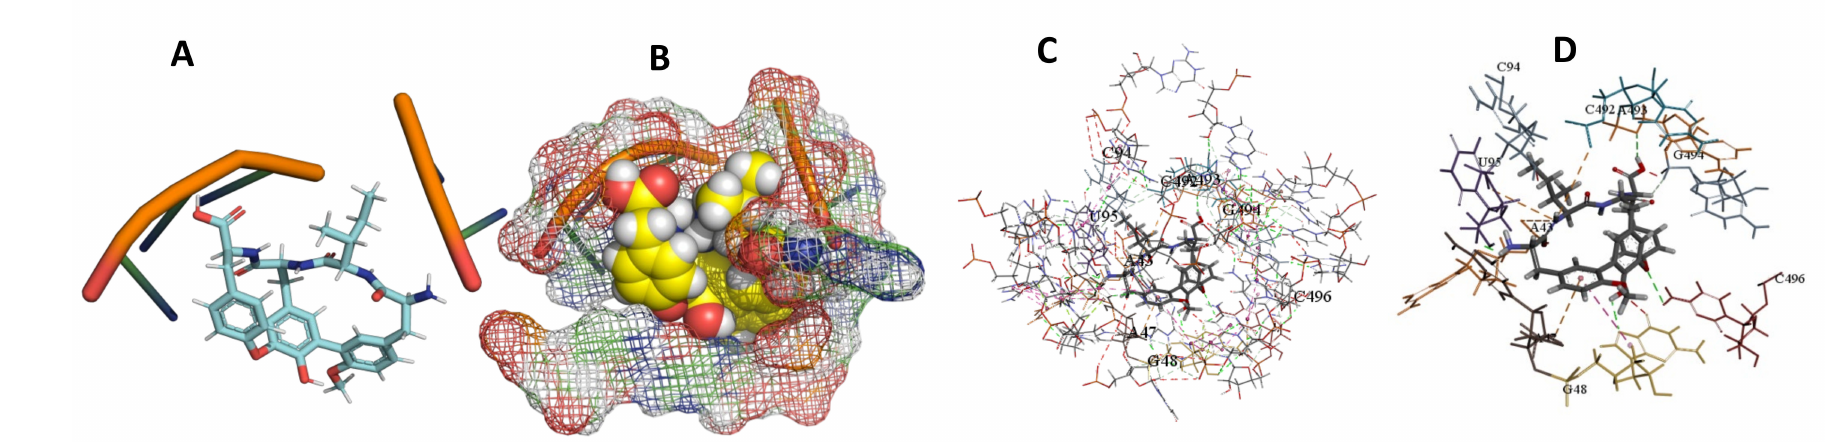
Figure 16. T. brucei + Cittilin. ( A ): Best binding pose and nucleotides involved. ( B ): Schematic binding pocket. ( C ): shows the Nucleotides component that re involved in binding. ( D ): Shows the main bonds involved between the compound and the nucleotide component.